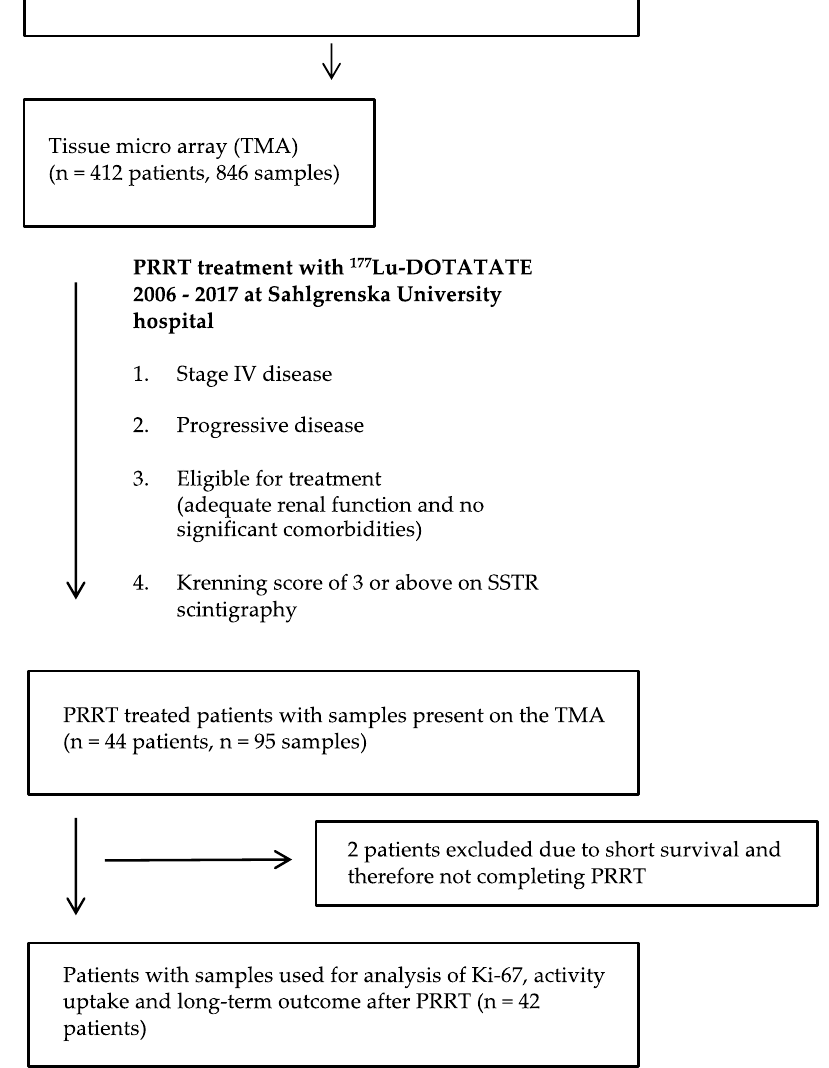
Figure 1. Flowchart describing identification of patient cohort and corresponding analysis.